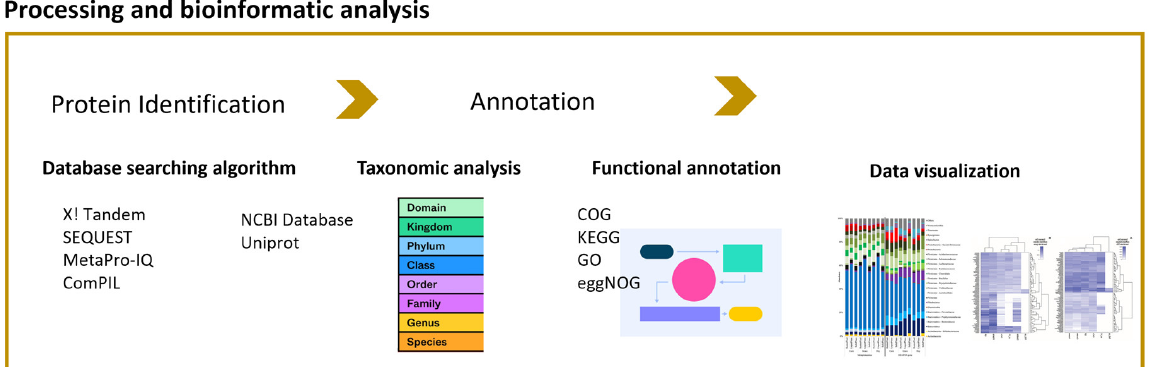
Figure 2. Shotgun metaproteomics approach to identify microbial proteins in human and ambient samples.